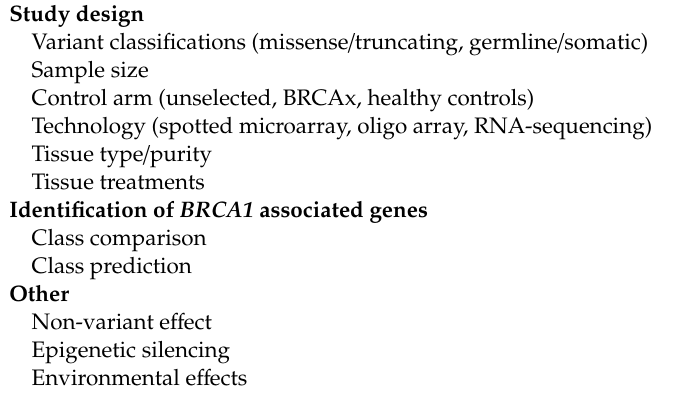
Table 4. Di ff erence in study design that limit